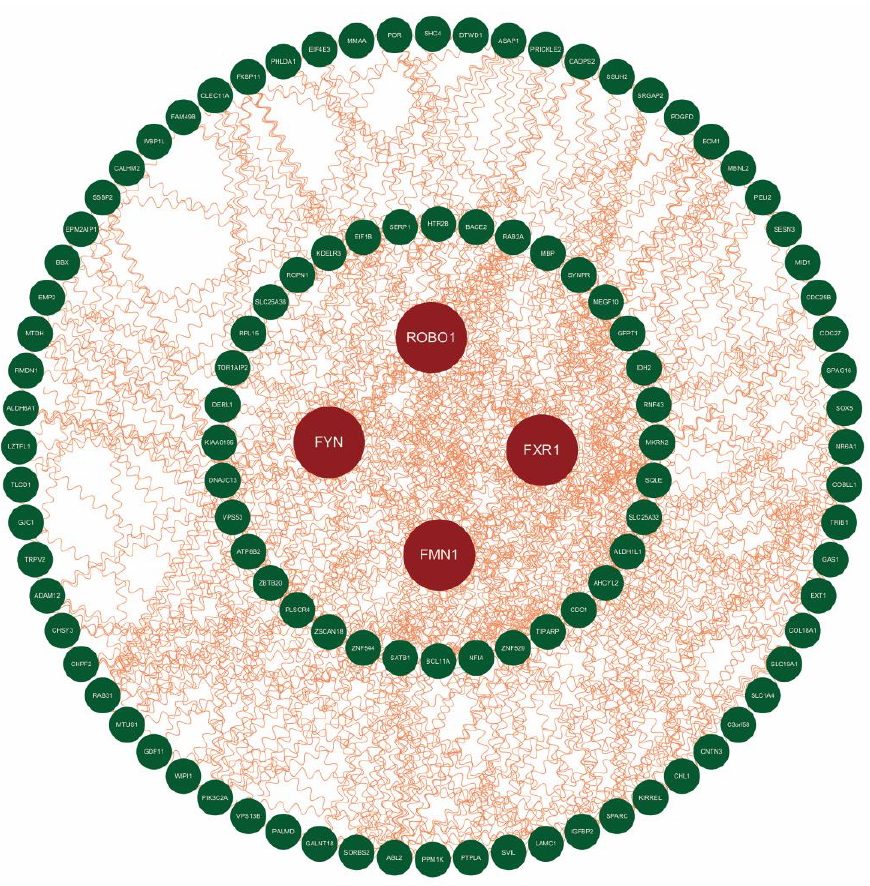
Figure 4. Protein–protein interaction (PPI) network of differentially expressed genes. Red represents the hub genes we selected.